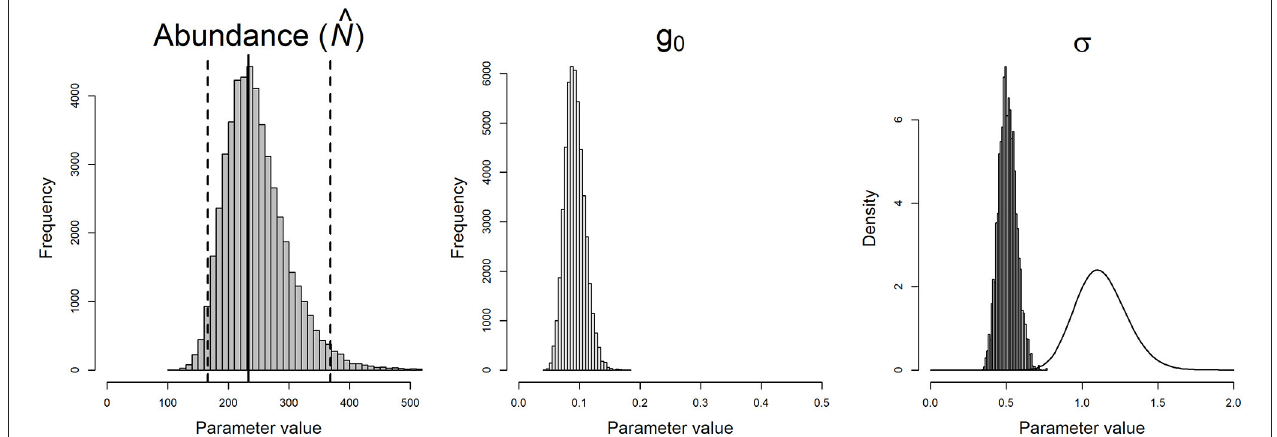
FIGURE 2 | Posterior distributions of Honey badger abundance ( ˆN ), and the parameters of the half-normal detection function (detection probability g 0 , spatial-scale parameter σ ) using the spatial presence-absence model applied to honey badger detections in cameras in the Tadoba-Andhari Tiger Reserve in central India, 2016. The solid line overlaid on the posterior distribution of σ is the prior gamma distribution (45,40) used for the